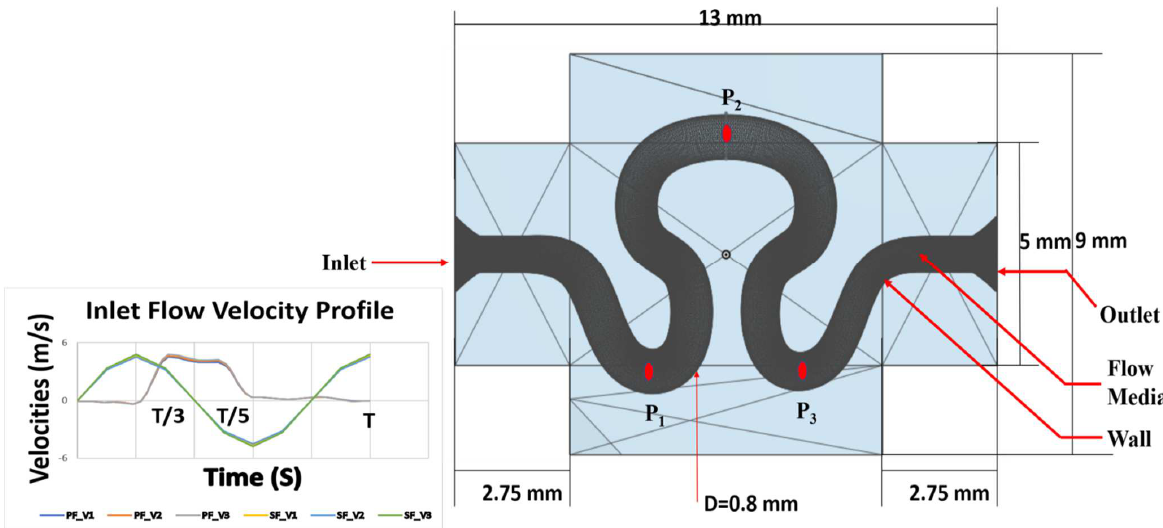
Figure 1. Schematic diagram of the proposed serpentine model . Three different flow rate based inlet velocity models of sinusoidal flow (SF) [V 1 = 4.48 mm/min, V 2 = 4.62 mm/min and V 3 = 4.76 mm/min] and physiological flow-PF [V 4 = 4.48 mm/min, V 5 = 4.62 mm/min and V 6 = 4.76 mm/min] were considered in the study. The physiological functions (waveform) were derived from 4D-Laser Doppler data of blood flow across a cross-section of sub-clavicular artery of healthy subject. The study was ap- proved by Institute Ethical Committee (NITRR/IEC/2021/12). Obtained tempero-spatial functions were interpolated thereafter using Curve-Fitting MATLAB toolbox version 2018a, Mathworks, India. Thereafter, the interpolated function with lowest RMSE value was selected for the study. The functions corresponding to inlet velocity models for V 1 to V 6 are given in Table 2. One complete cycle of both sinusoidal and physiological flow corresponds to one complete cardiac cycle (represented by T). Different study conditions were formulated based on the above boundary conditions: no-slip (wall) and sinusoidal inlet flow, slip (wall) and sinusoidal inlet flow, no-slip (wall) and physiological inlet flow, slip (wall) and physiological inlet flow (as tabulated in Table 3). A no-slip boundary con- dition will exclusively provide the influence of inlet flow type in the development of flow physics of media inside the serpentine. On the other hand, slip wall boundary condition will simulate the elasticity of the serpentine wall (similar to the natural blood vessel wall). Table 2. Velocity function for V 1 to V 6. Inlet Velocity